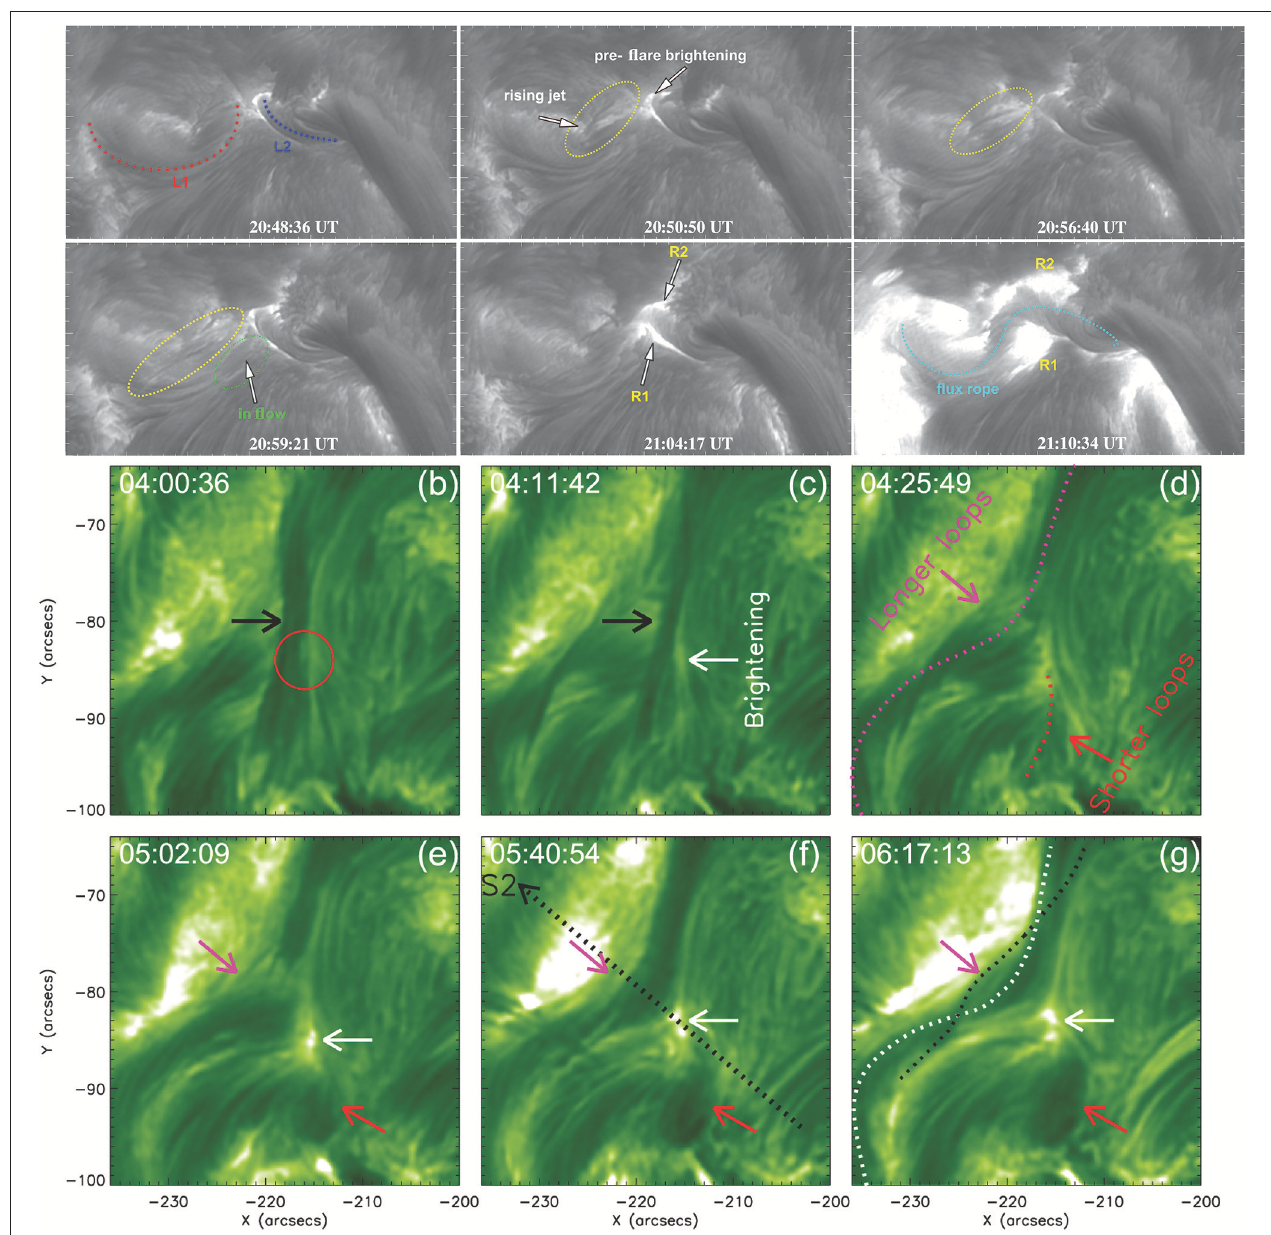
FIGURE 3 | Upper BBSO/GST H α line center images of NOAA active region 12087 on 2014 June 12, showing the formation of a S-shaped twisted flux rope between two pre-existing H α loops L1 and L2 by magnetic reconnection. The reconnection is associated with rising untwisting jets (yellow ellipse) and cool plasma inflow (green ellipse) and produces a two-ribbon (R1 and R2) M1.0 flare. The field of view is 32 ′′ × 17 ′′ (Kumar et al., 2015). Lower NVST H α images of NOAA active region 11967 on 2014 February 2, showing that the reconnection between two sheared arcades produces a long flux rope (pink dotted line and arrow) with fine threads (e.g., those delineated by the black and white dotted lines) and shorter loops (red dotted line and arrow). The black and white arrows mark the quick disappearing part of one arcade and brightening region, respectively (Xue et al., 2017). Reproduced by permission of AAS.